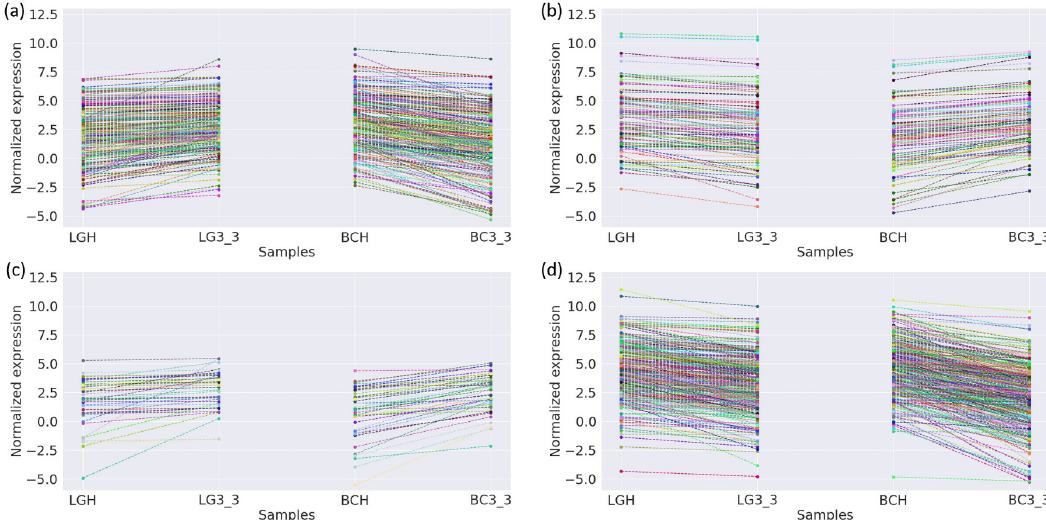
Fig 4. Clustering and classification of genes differentially-expressed within ‘Bluecrop’ and ‘Legacy’ into the four biological expression profiles (a) up-regulated in ‘Legacy’ and down-regulated in ‘Bluecrop’ (b) Down-regulated in ‘Legacy’ and up-regulated in ‘Bluecrop’ (c) Up-regulated in both ‘Legacy’ and ‘Bluecrop’ (d) Down-regulated in both ‘Legacy’ and ‘Bluecrop’. The labels LG and BC indicate ‘Legacy’ and ‘Bluecrop’ whilst H indicates samples from harvest and 3_3 indicates samples from 24 days post harvest.